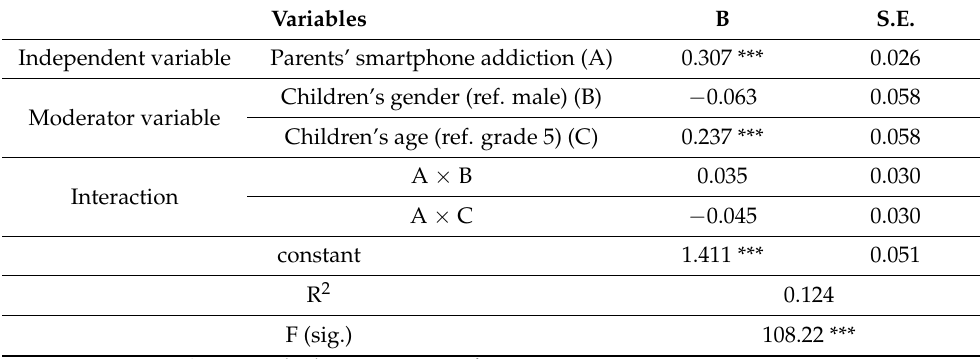
Table 5. Research model analysis. Variables